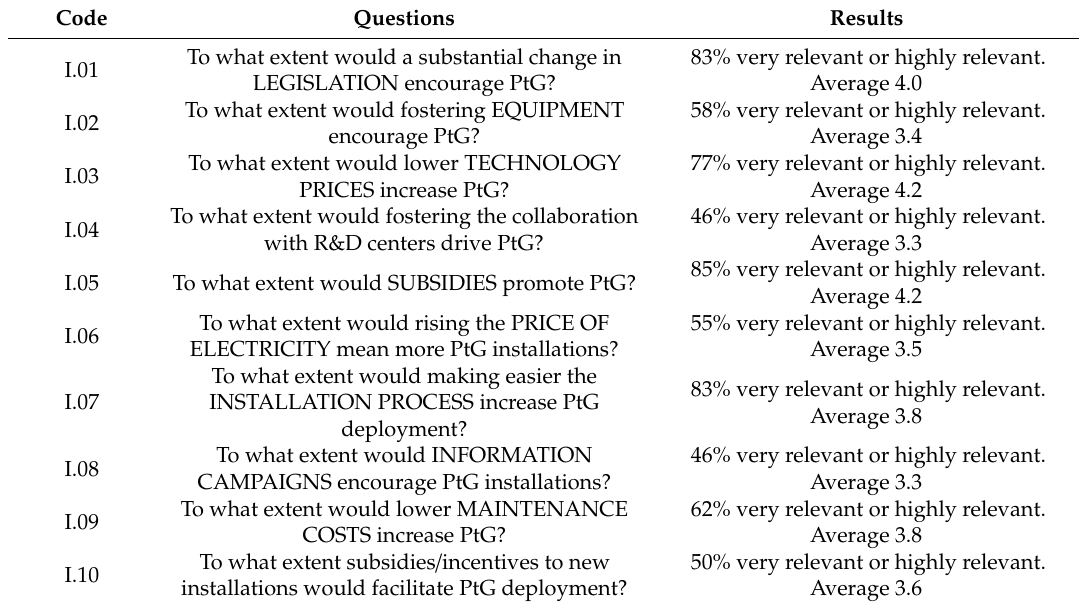
Table 3. Results of the experts’ interviews regarding incentives to